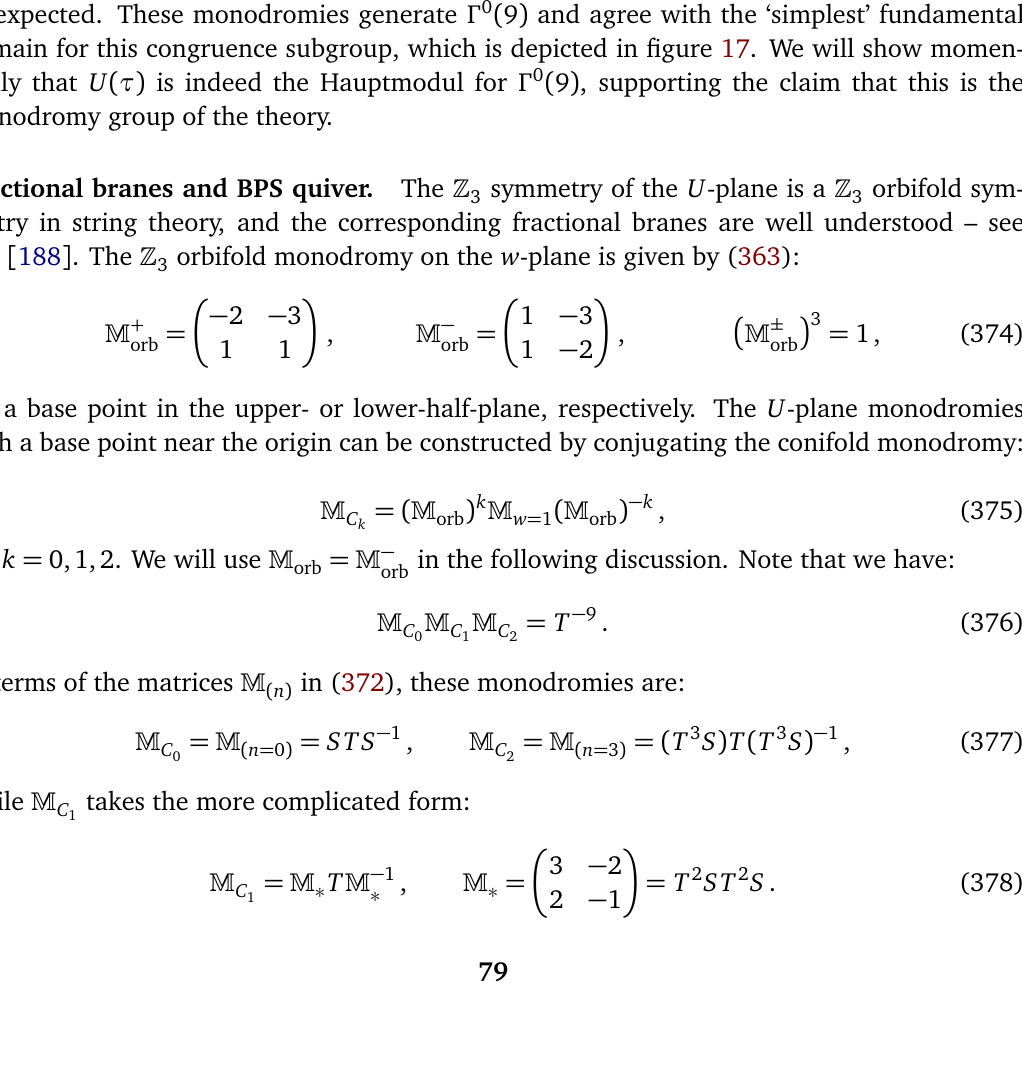
cusps at τ = 0, 3 and